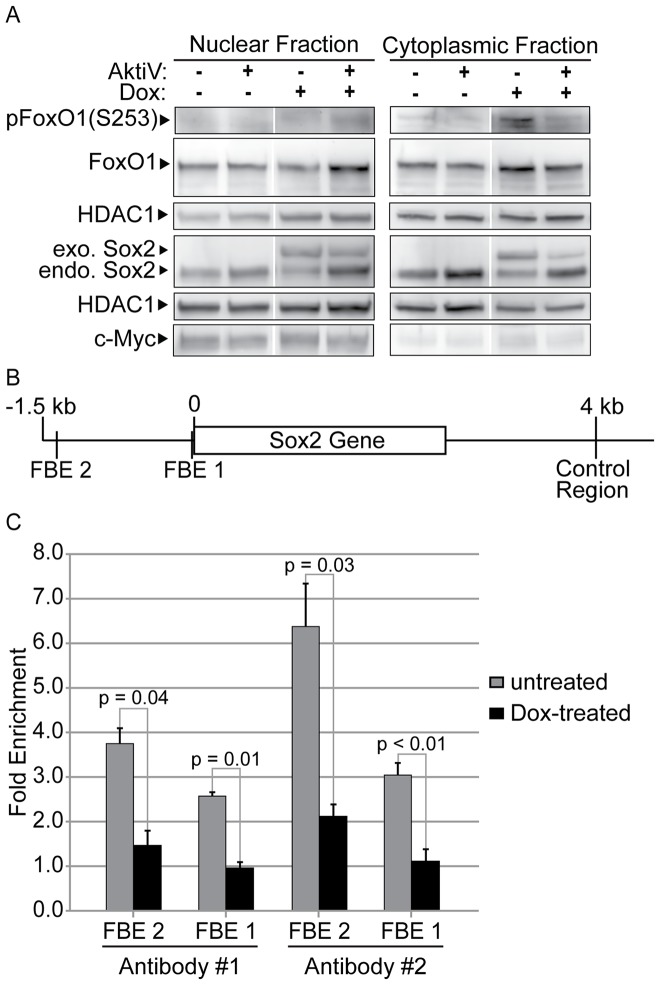
Elevated Sox2 alters FoxO1 phosphorylation and its binding to regulatory regions of the Sox2 gene.i-OSKM-ESC were seeded at 1.5×106 per 100 mm dish with or without 4 μg/ml Dox for 24 hours. (A) After the initial 24 hours, the cells were refed with fresh medium with or without 4 μg/ml Dox, and treated with 5 μM AKTiV for an additional 24 hours where indicated. 48 hours after the cells were plated, nuclear and cytoplasmic protein extracts were prepared and equal amounts of nuclear and cytoplasmic protein were loaded into each well of an SDS-PAGE. Western blot analysis was performed by sequentially probing for pFoxO1(S253), total FoxO1, Sox2, HDAC1, and c-Myc. HDAC1 was used as a loading control for two separate western blots performed with the same protein extracts. c-Myc was used as a loading control to confirm proper separation of nuclear and cytoplasmic extracts. The levels of c-Myc in nuclear and cytoplasmic extracts were monitored simultaneously in western blots that were imaged together. (B) Schematic of the location of FBE1, FBE2, and the Sox2 control region within the regulatory regions of the Sox2 gene. (C) Chromatin immunoprecipitation (ChIP) analysis of DNA immunoprecipitated from untreated or Dox-treated i-OSKM-ESC using two different anti-FoxO1 antibodies (#1: Cell Signaling Technology, #2: Santa Cruz) and an IgG (GFP) control antibody for normalization. Analysis was performed in triplicate by qPCR and the values for the FoxO1 immunoprecipitated DNA were normalized to the input samples and the control antibody. The fold change of FoxO1 binding was determined by comparing FoxO1 antibody immunoprecipitation of FBE1 and FBE2 to immunoprecipitation of the Sox2 control region from untreated and Dox-treated i-OSKM-ESC. The results are presented as averages of the triplicate results and error is presented as the standard error of the mean. These findings are statistically significant with p-values all <0.05, as determined by Student's t-test.